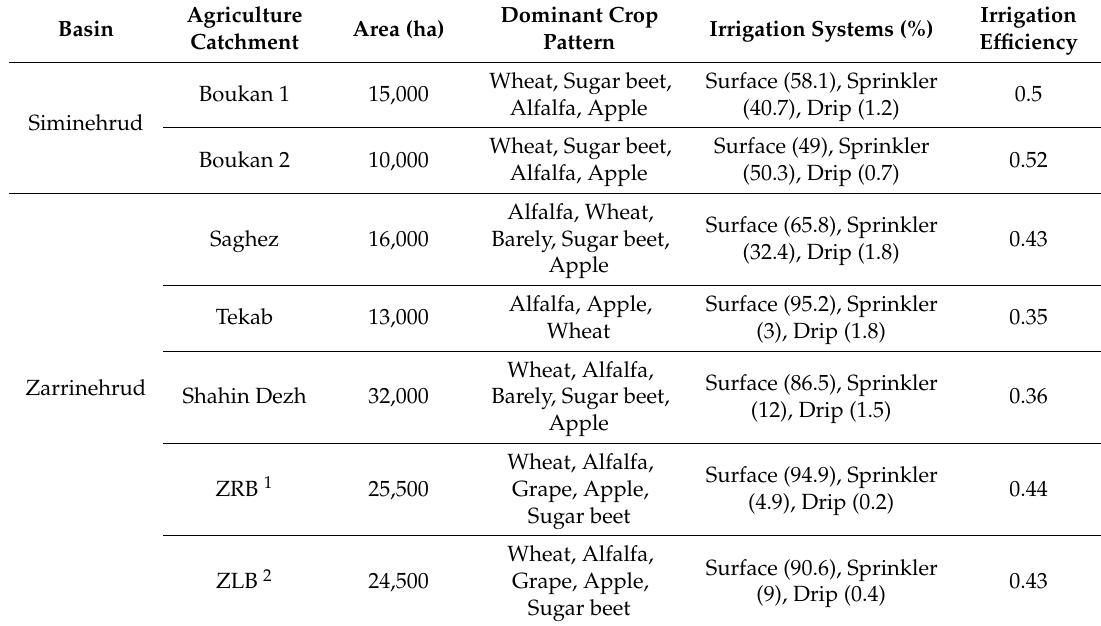
Table 1. Specifications of agriculture catchments in the current account (2015) [38–40].